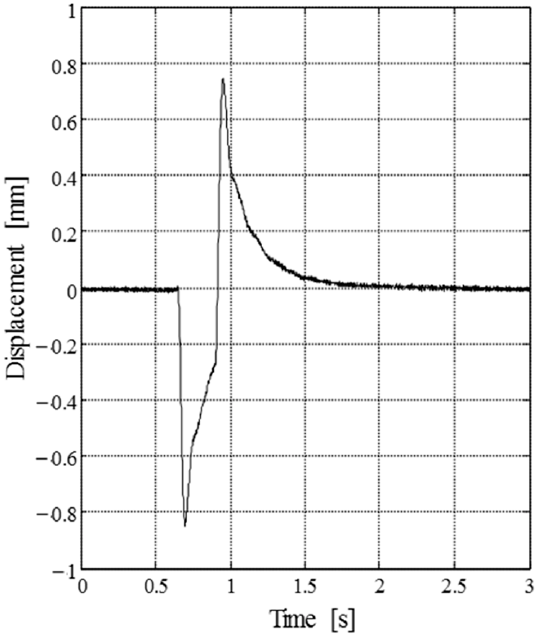
Figure 12. The time series of frame displacement data for a pulse disturbance.